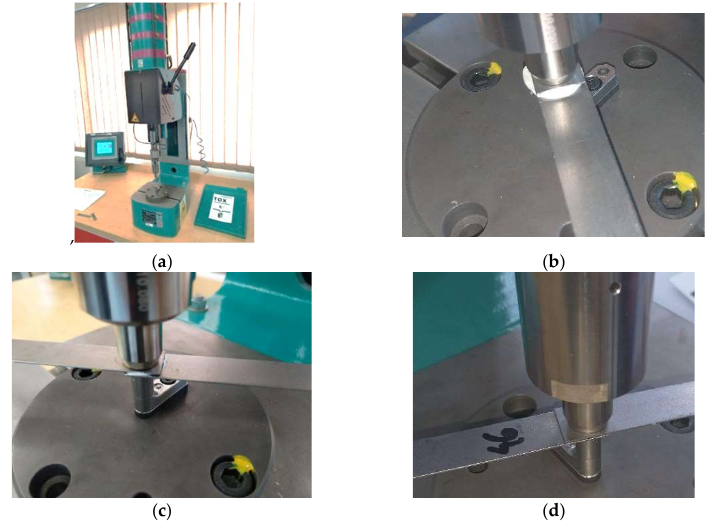
Figure 6. Execution of sheet metal clinching; ( a ) the device used to prepare clinching joint, ( b ) speci- men from the first testing series, ( c ) specimen from the second testing series, ( d ) specimen from the third testing